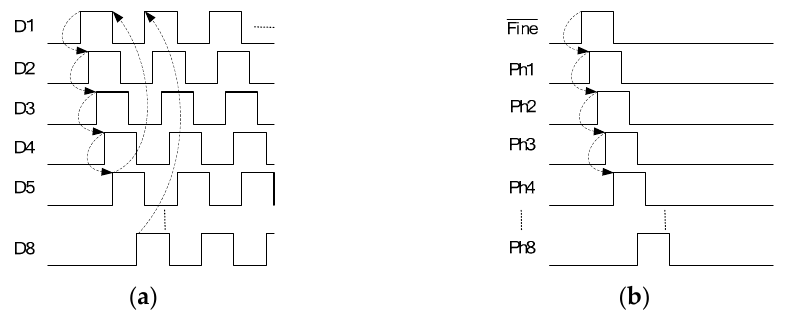
Figure 9. ( a ) Delay line oscillators and ( b ) delay line of timing diagram.